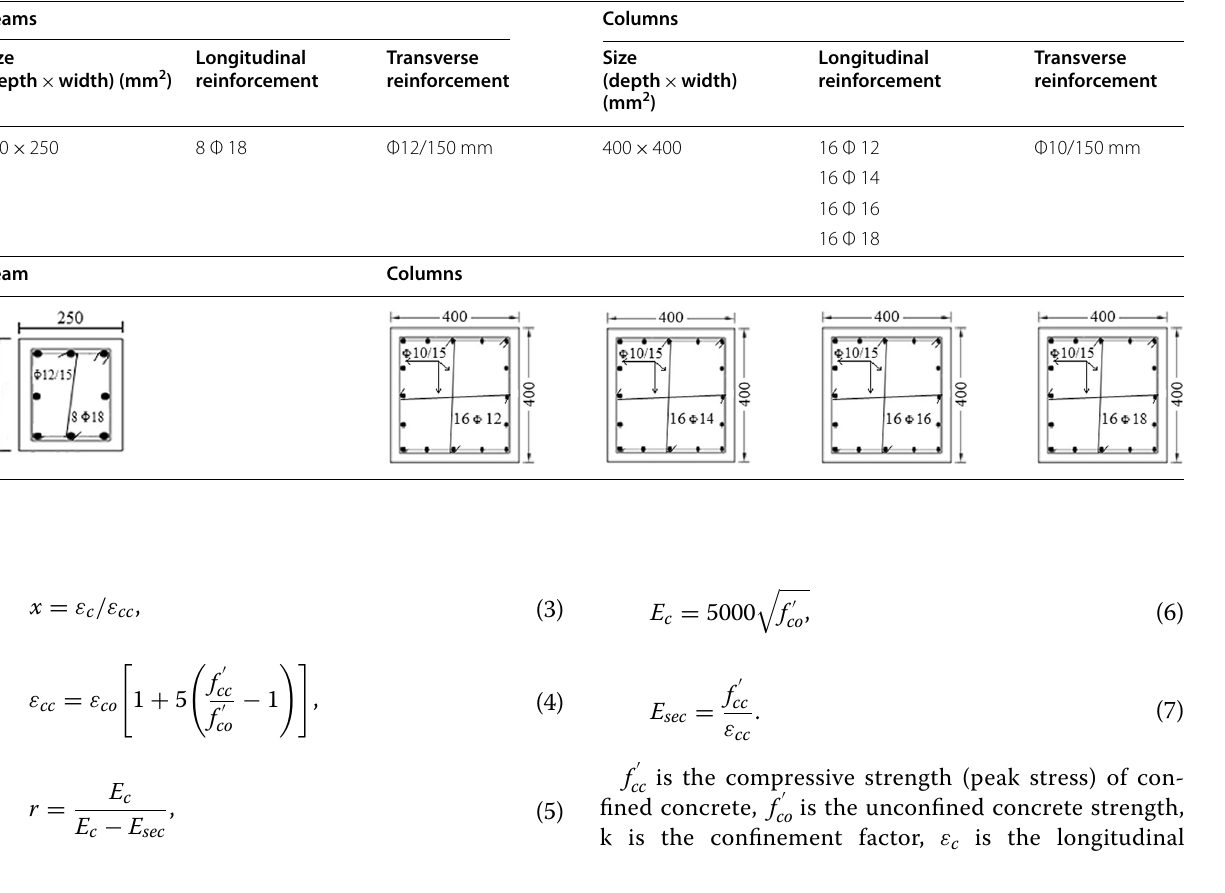
Table 4 Dimensional specification and the reinforcement Layout of the 20-story